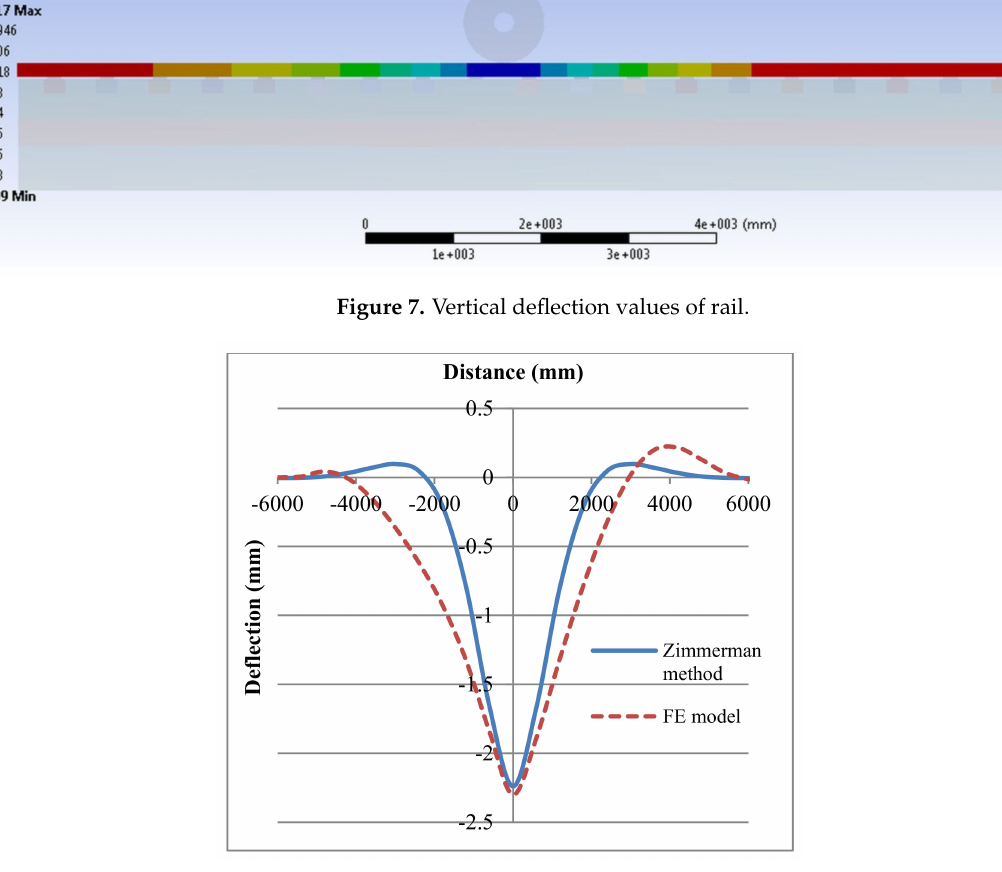
Figure 8. Comparison of the deflection between the Zimmermann method and FEM. Table 3. Calculation values of rail deflection according to the Zimmermann